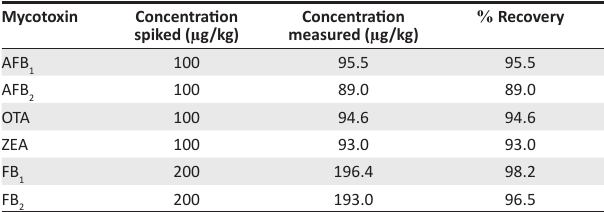
TABLE 1: High-performance liquid chromatography recovery of the selected mycotoxins after spiking with appropriate amounts of the pure standard. Mycotoxin